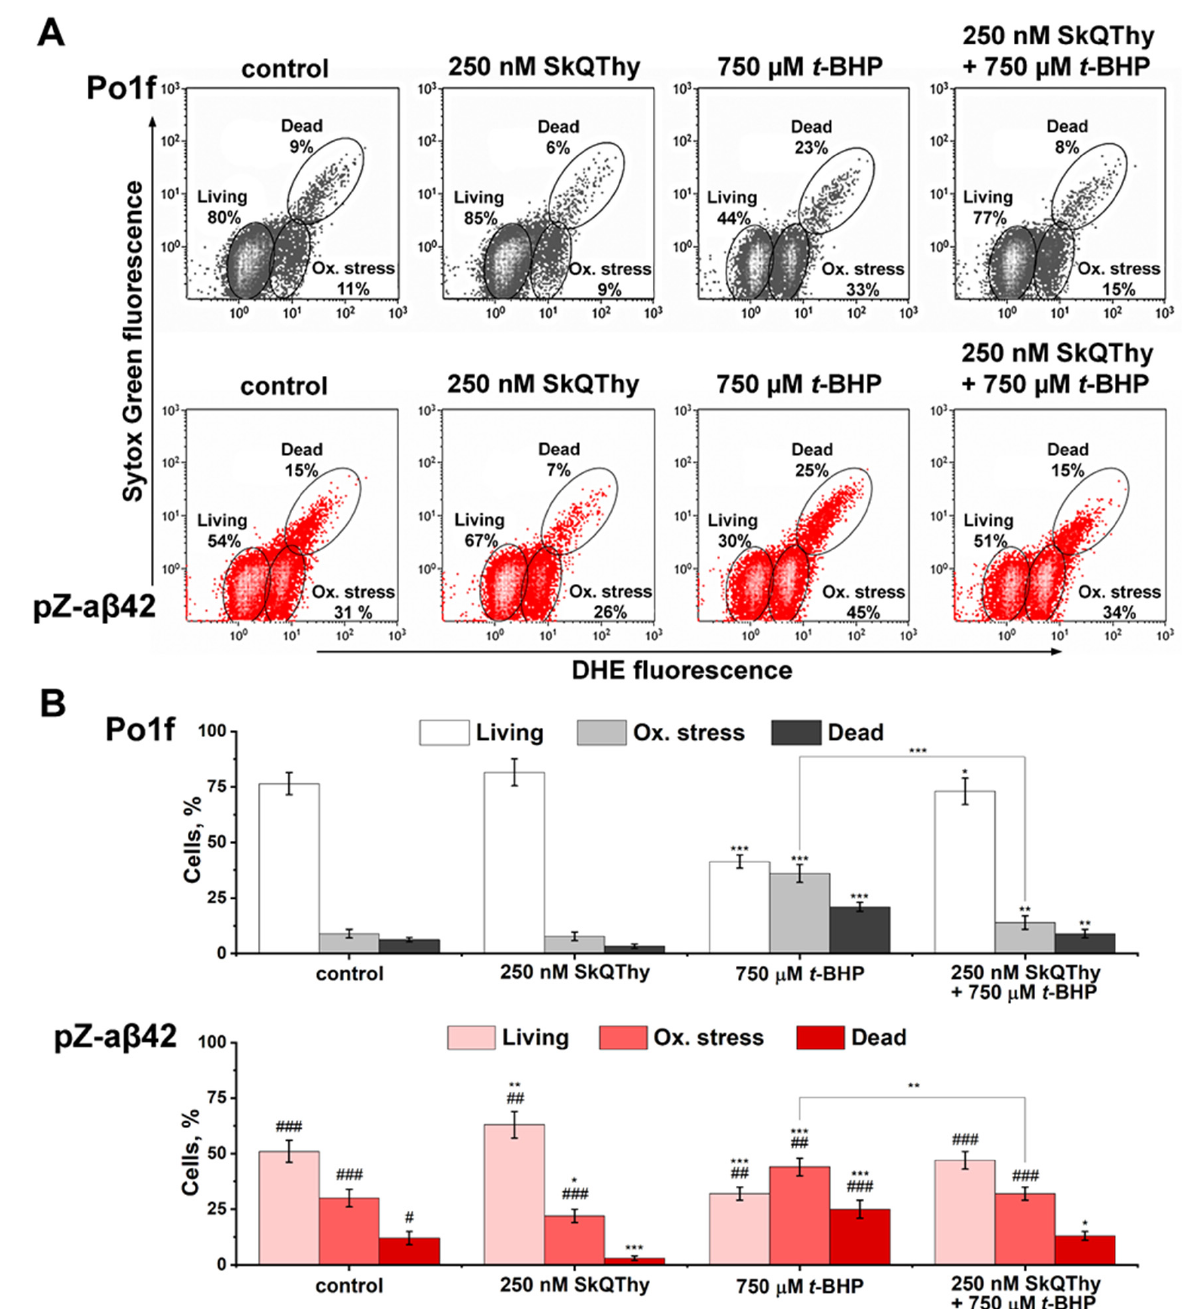
Figure 3. Oxidative stress and cell death in the Y. lipolytica strains Po1f (the control, top panel) and pZ-A β 42 cells (bottom panel). Effects of the prooxidant t-BHP and antioxidant SkQThy. ( A ) Flow cytometry measurements. The results of one representative experiment are presented. ( B ) Histograms of the results obtained by the low cytometry measurements from three independent experiments. Statistical analyses were carried out by the one-way ANOVA test. Symbols: * marks differences between the results obtained for the Po1f strain under different conditions; *** p < 0.001, ** 0.001 < p < 0.01, * 0.01 < p < 0.05; # marks differences between the Po1f and pZ-A β 42 samples; ### p < 0.001, ## 0.001 < p < 0.01, # 0.01 < p <